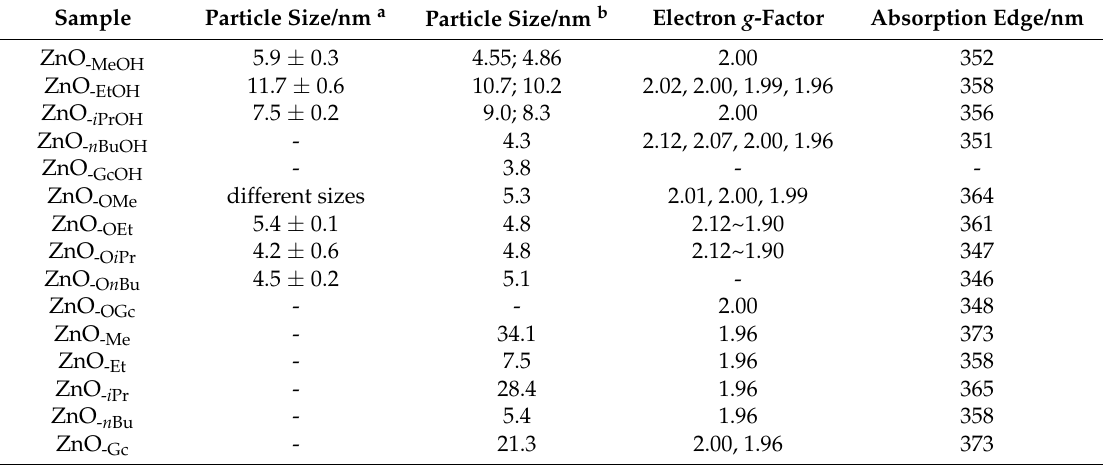
Figure 2. (High-resolution) TEM images of the crystalline ZnO -MeOH NPs with visual lattice fringes (correspond to crystal planes). Table 1. Particle size determined by TEM and XRD data and absorption peak from UV spectra.